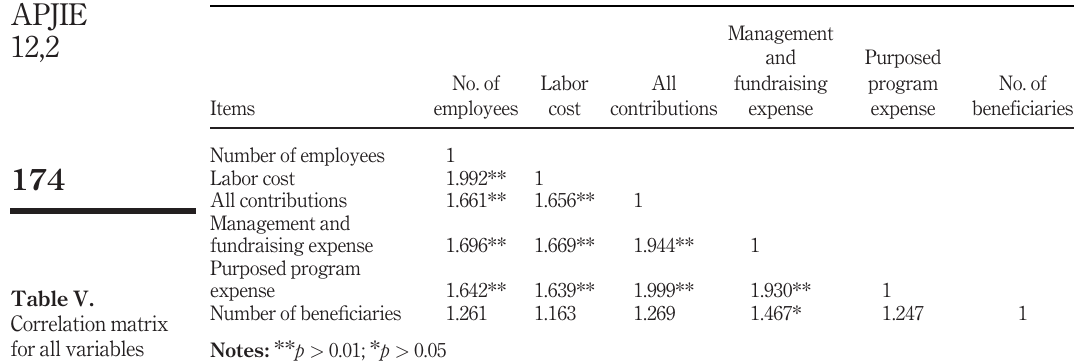
Table V. Correlation matrix for all variables